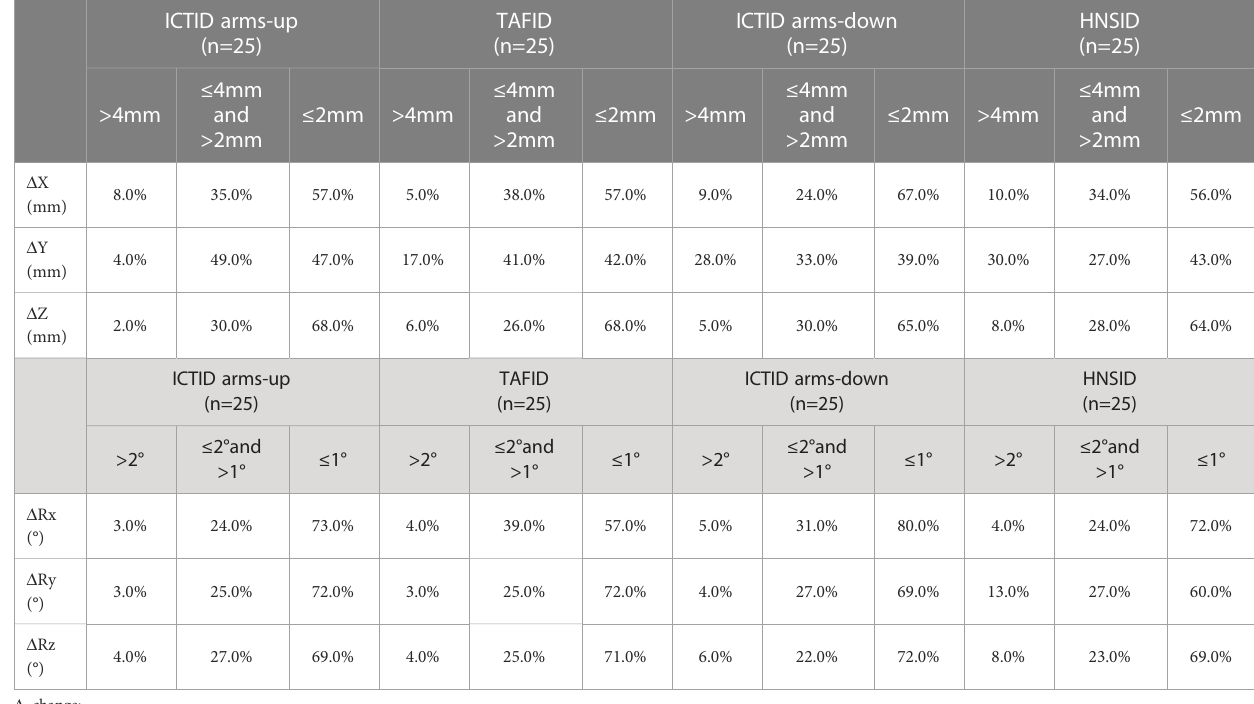
TABLE 3 Setup error distribution of the four immobilization